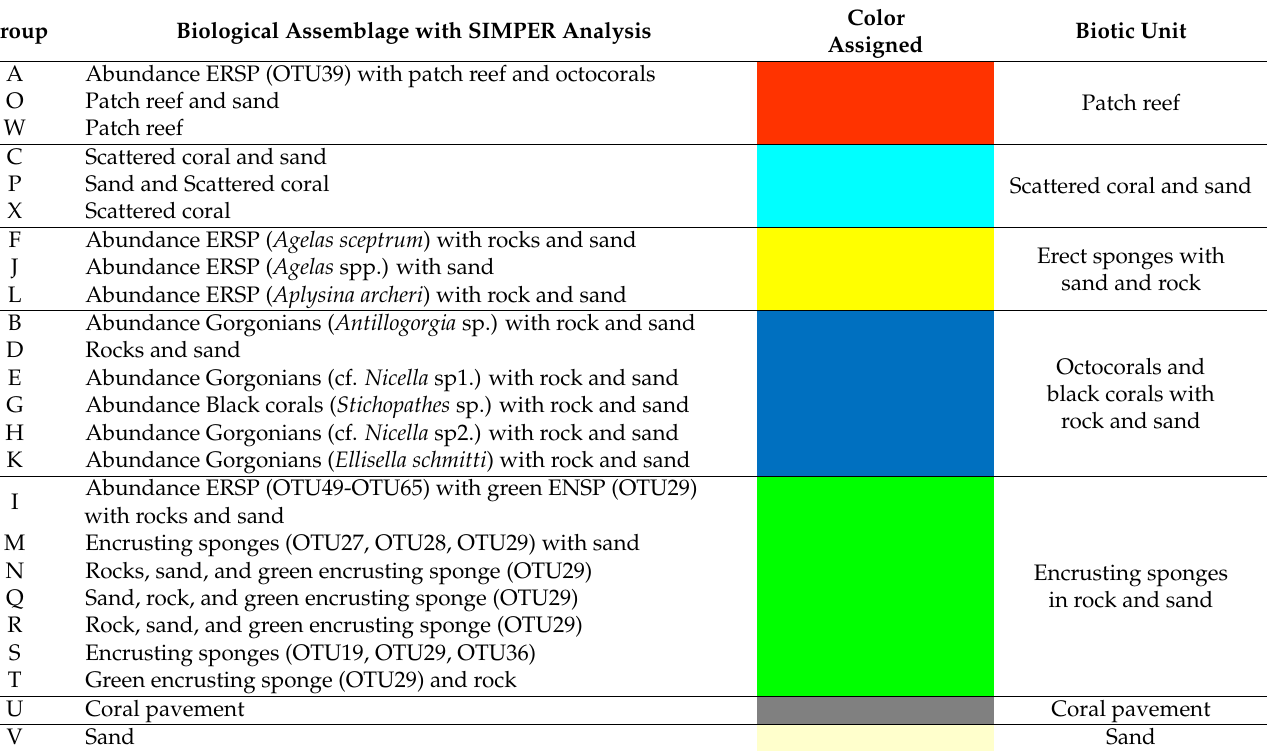
ERSP: Erect sponges. ENSP: Encrusting sponges. The spatialization process employed the bathymetric 3D model [28], and isobaths between 30–140 m generated with the Contour tool of ArcGis 10.6 software [20]. Likewise, terrain, employing the bathymetric and the shadow model of this side of the island [28].